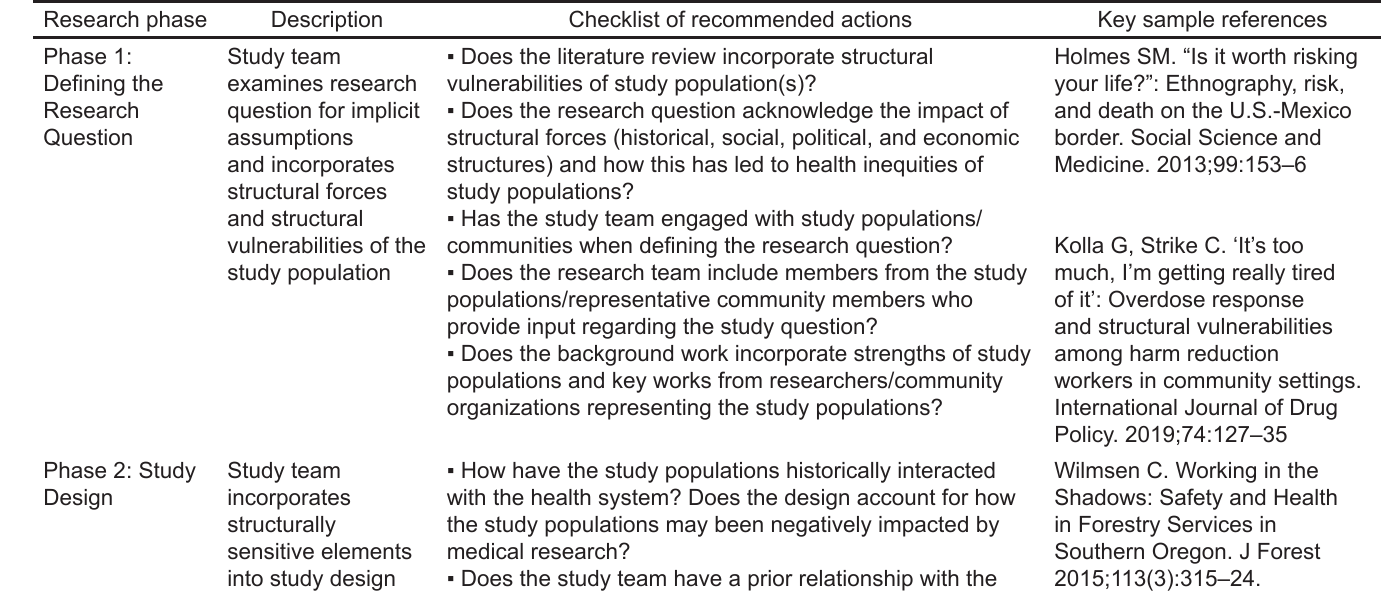
Table 3. Structural competency framework